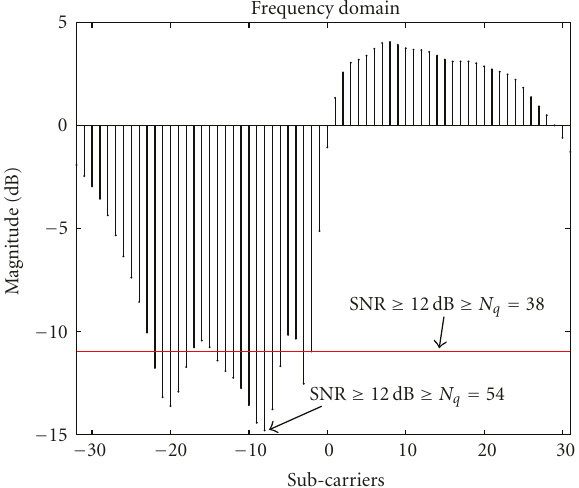
Figure 3: The di ff erence in the number of ADC levels N q between the transmission Scheme I and the transmission Scheme II. In this example, N q = 54 levels are required for the transmission Scheme I such that each Fountain packet is transmitted over all subcarriers; N q can be reduced to 38 levels when 15 subcarriers are discarded in the transmission Scheme II where each Fountain packet is transmitted over one subcarrier